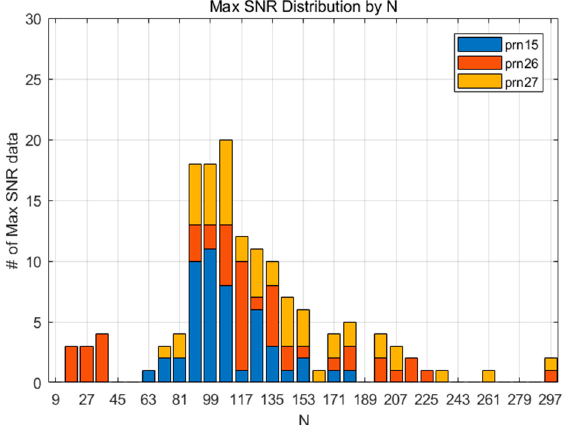
Figure 6. The maximum SNR distribution according to various values of N (FDMA) .